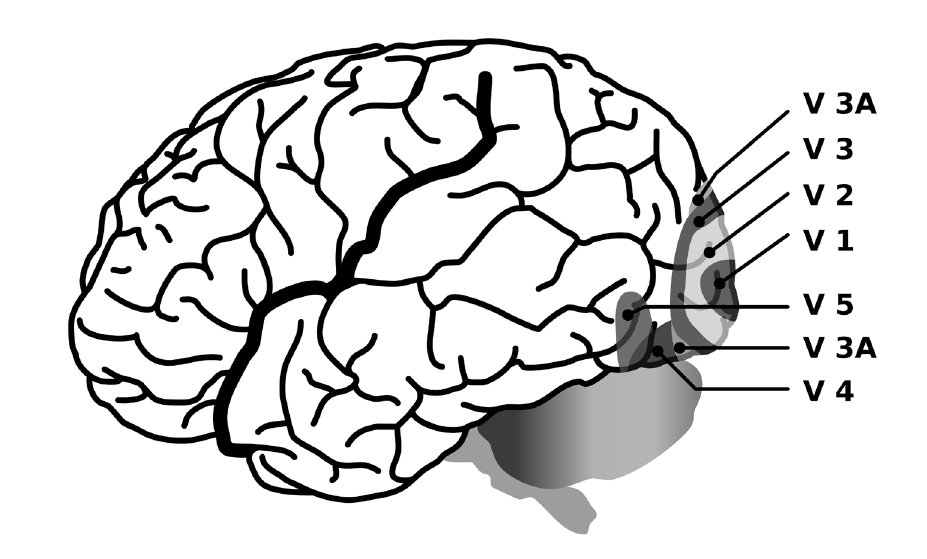
Figure 1. Areas of the brain relating to visual